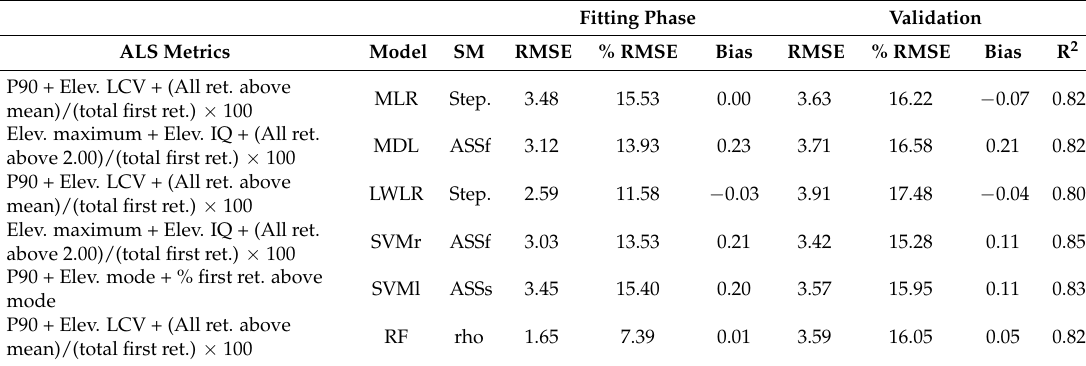
Table A7. Summary of the Dg models using 2016 ALS data. Validation results in terms of RMSE (cm), %RMSE, and bias (cm) and R 2 . SM refers to selection method; Step. stands for Stepwise both and forward; SVMr. refers to Support Vector Machine with radial kernel; SVM l. refers to Support Vector Machine with linear kernel; ret. refers to